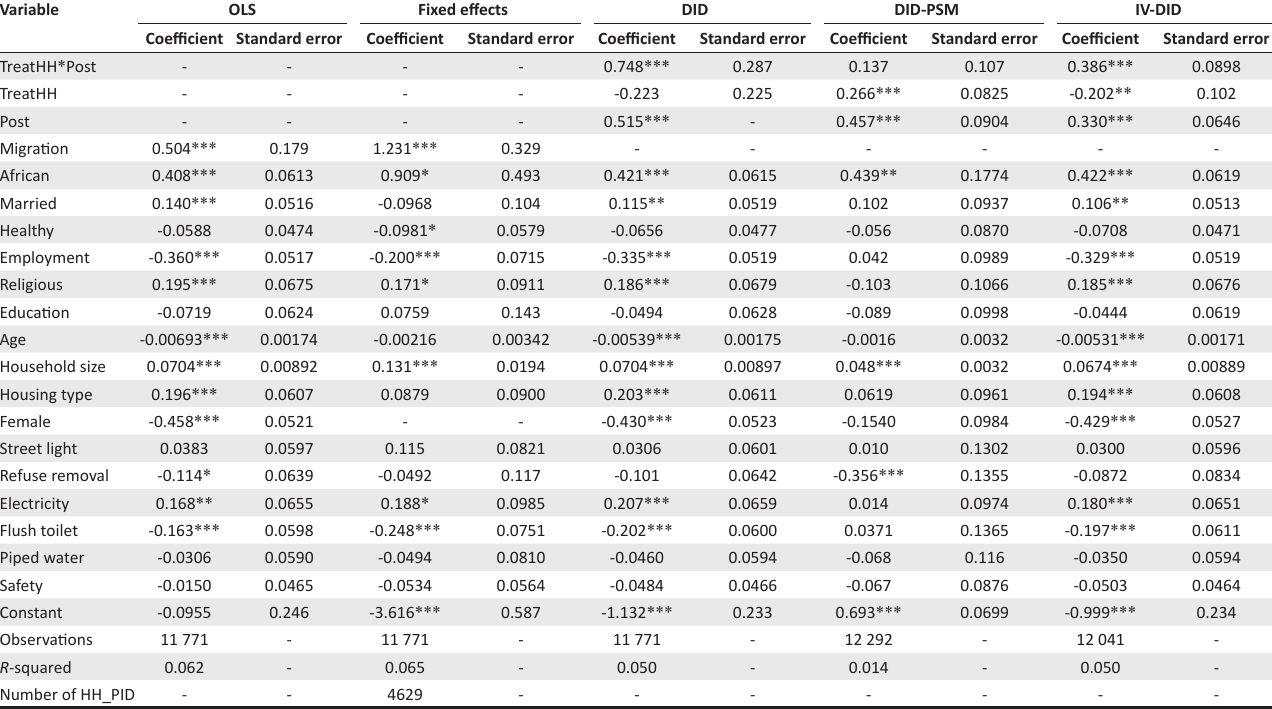
TABLE 7: Impact of migration on the value of remittances received by the sending household. Variable OLS Fixed